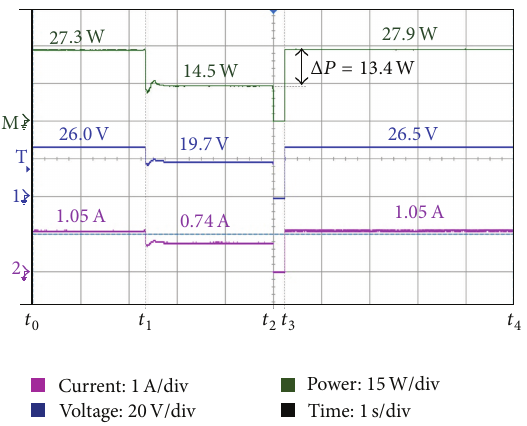
Figure 14: Experimental results: CF.02-CF.03.